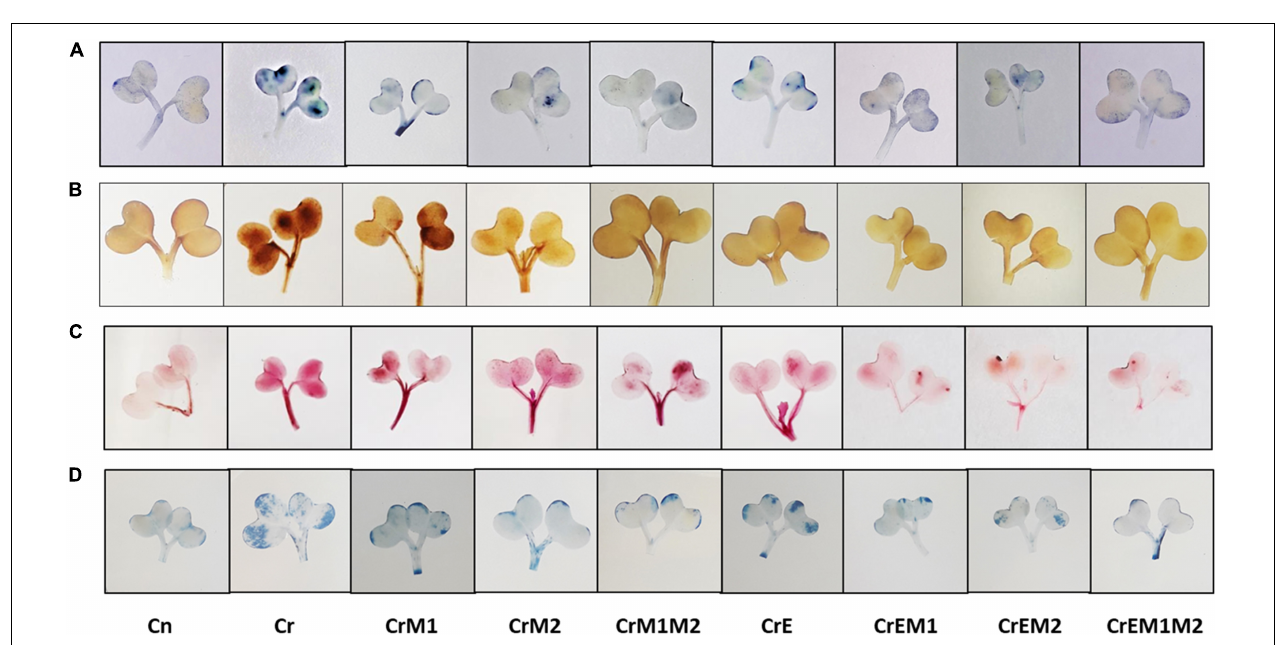
FIGURE 3 | In vivo imaging of (A) superoxide anion (O 2 • − ) stained with NBT, (B) hydrogen peroxide (H 2 O 2 ) detected using DAB, (C) lipid peroxidation, asMDA content stained using Schiff’s reagent, and (D) cell viability visualized using Evan’s blue in B. juncea seedlings, under Cr stress.